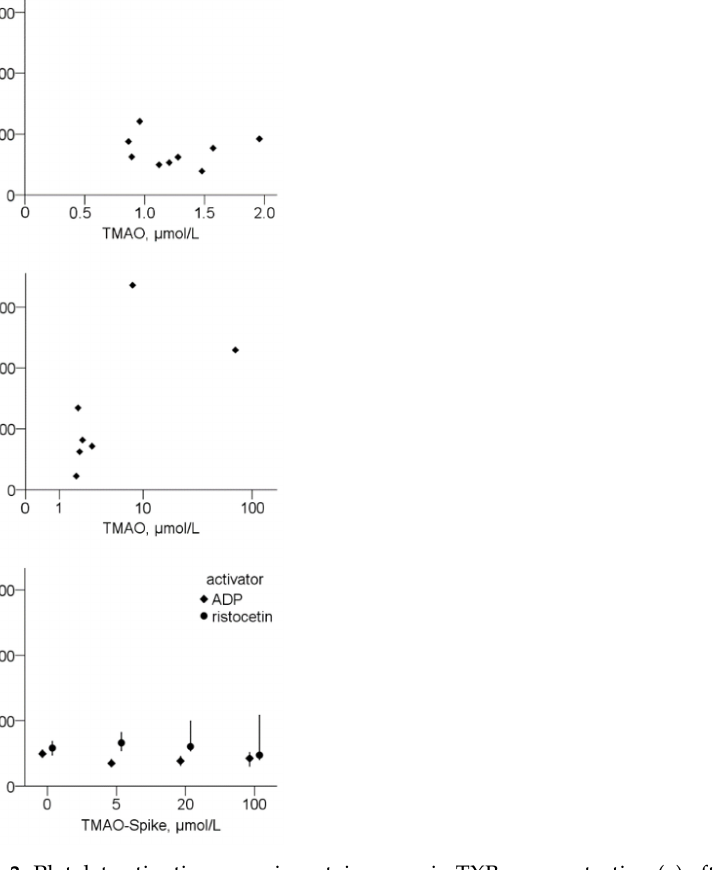
Figure 3. Platelet activation experiment, increase in TXB 2 concentration ( a ) after platelet activation with ristocetin at physiological TMAO plasma concentrations (intra-individual variation; one subject, nine subsequent days; experimental series 1), ( b ) after platelet activation with ristocetin at phys- iological TMAO plasma concentrations (inter-individual variation; seven subjects; experimental series 2), ( c ) as median (95% CI) after platelet activation with ristocetin (dots) or ADP (squares) in TMAO-spiked samples (one subject, three experimental repeats; experimental series 3). TMAO indicates trimethylamine-N-oxide; TXB 2 , thromboxane B 2